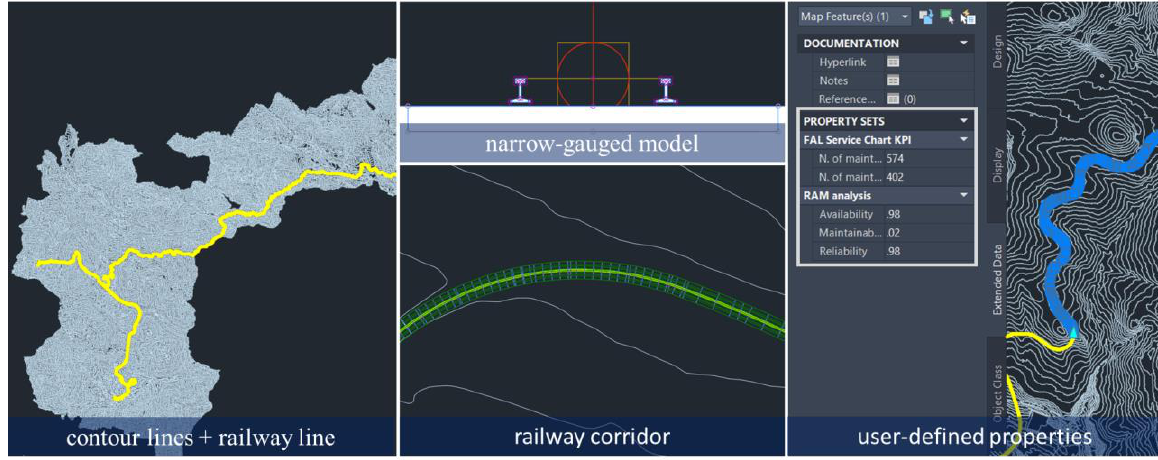
Figure 6 . BIM model and